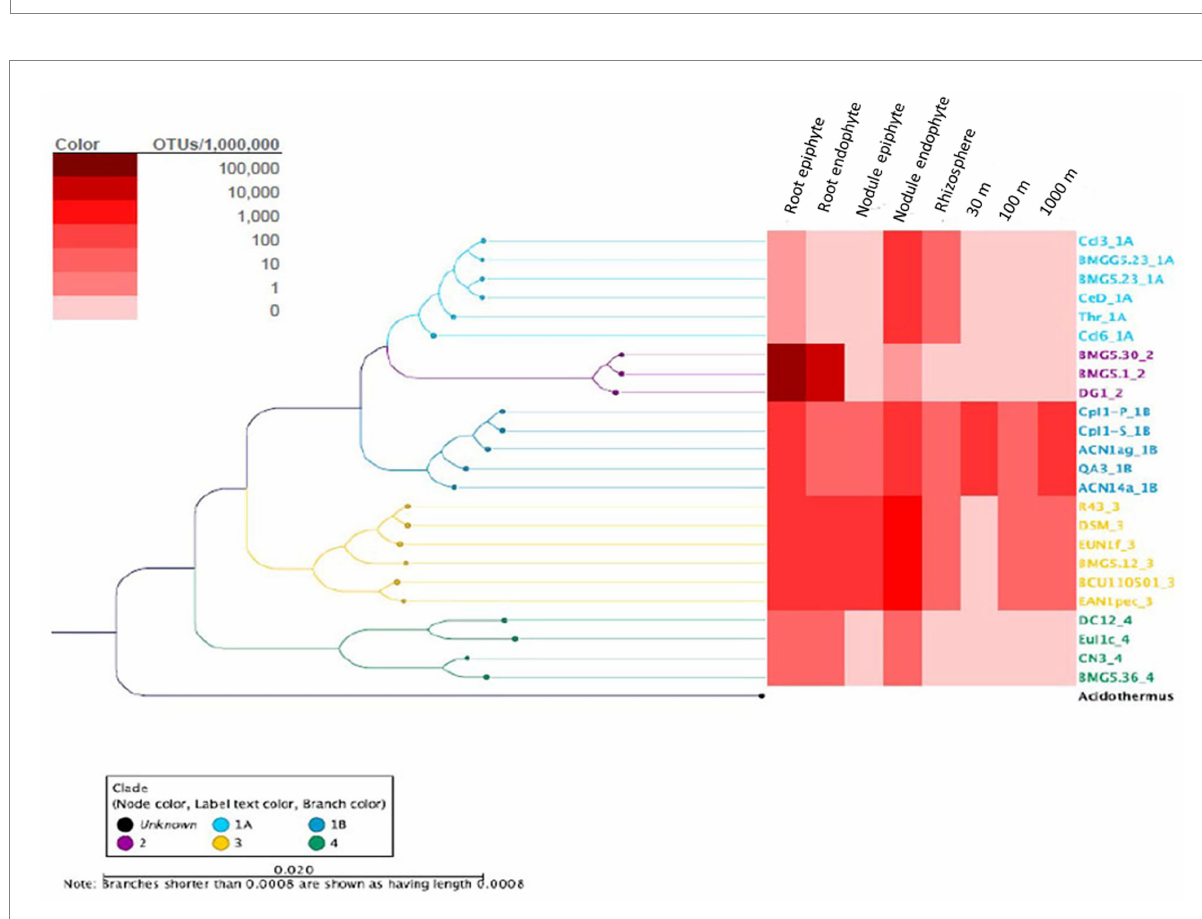
FIGURE 8 Remapped Frankia genus reads to clade level phylogeny. Coriaria myrtifolia rhizosphere, root, nodule, and nearby soil samples are shown. Endophyte and epiphyte communities of the nodule and root samples are shown. Rhizosphere and bulk soil samples and distance from the plant are also presented. Heat-map colors correspond to reads per million for a given set of